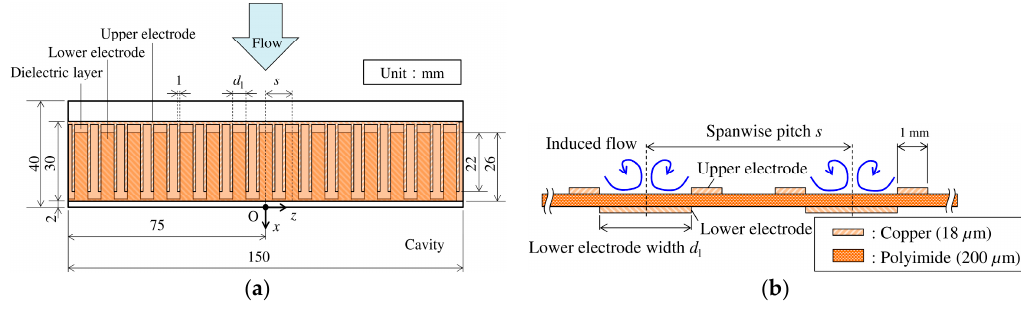
Figure 5. Configuration of the streamwise plasma actuators: ( a ) top view; and ( b ) view in a cross-section perpendicular to the streamwise direction.